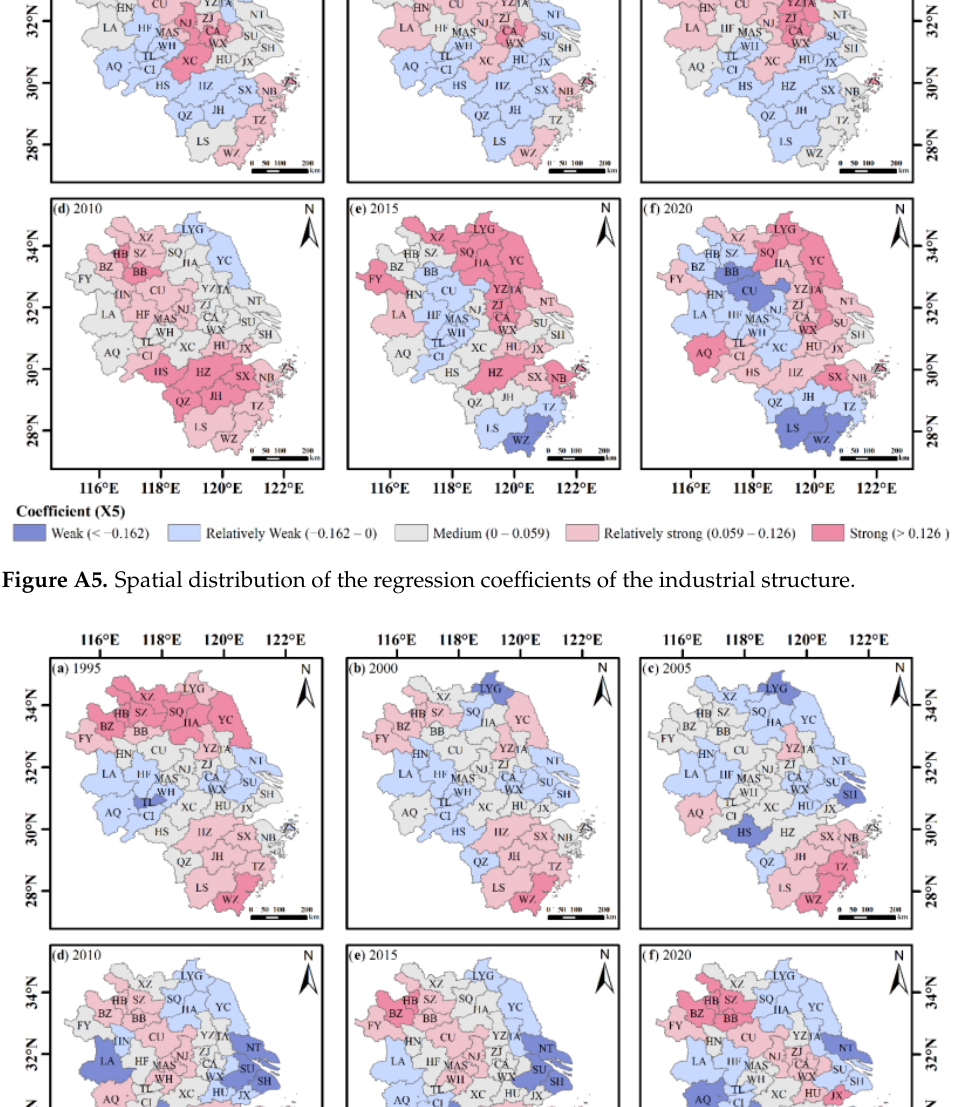
Figure A4. Spatial distribution of the regression coefficients of the population urbanization.